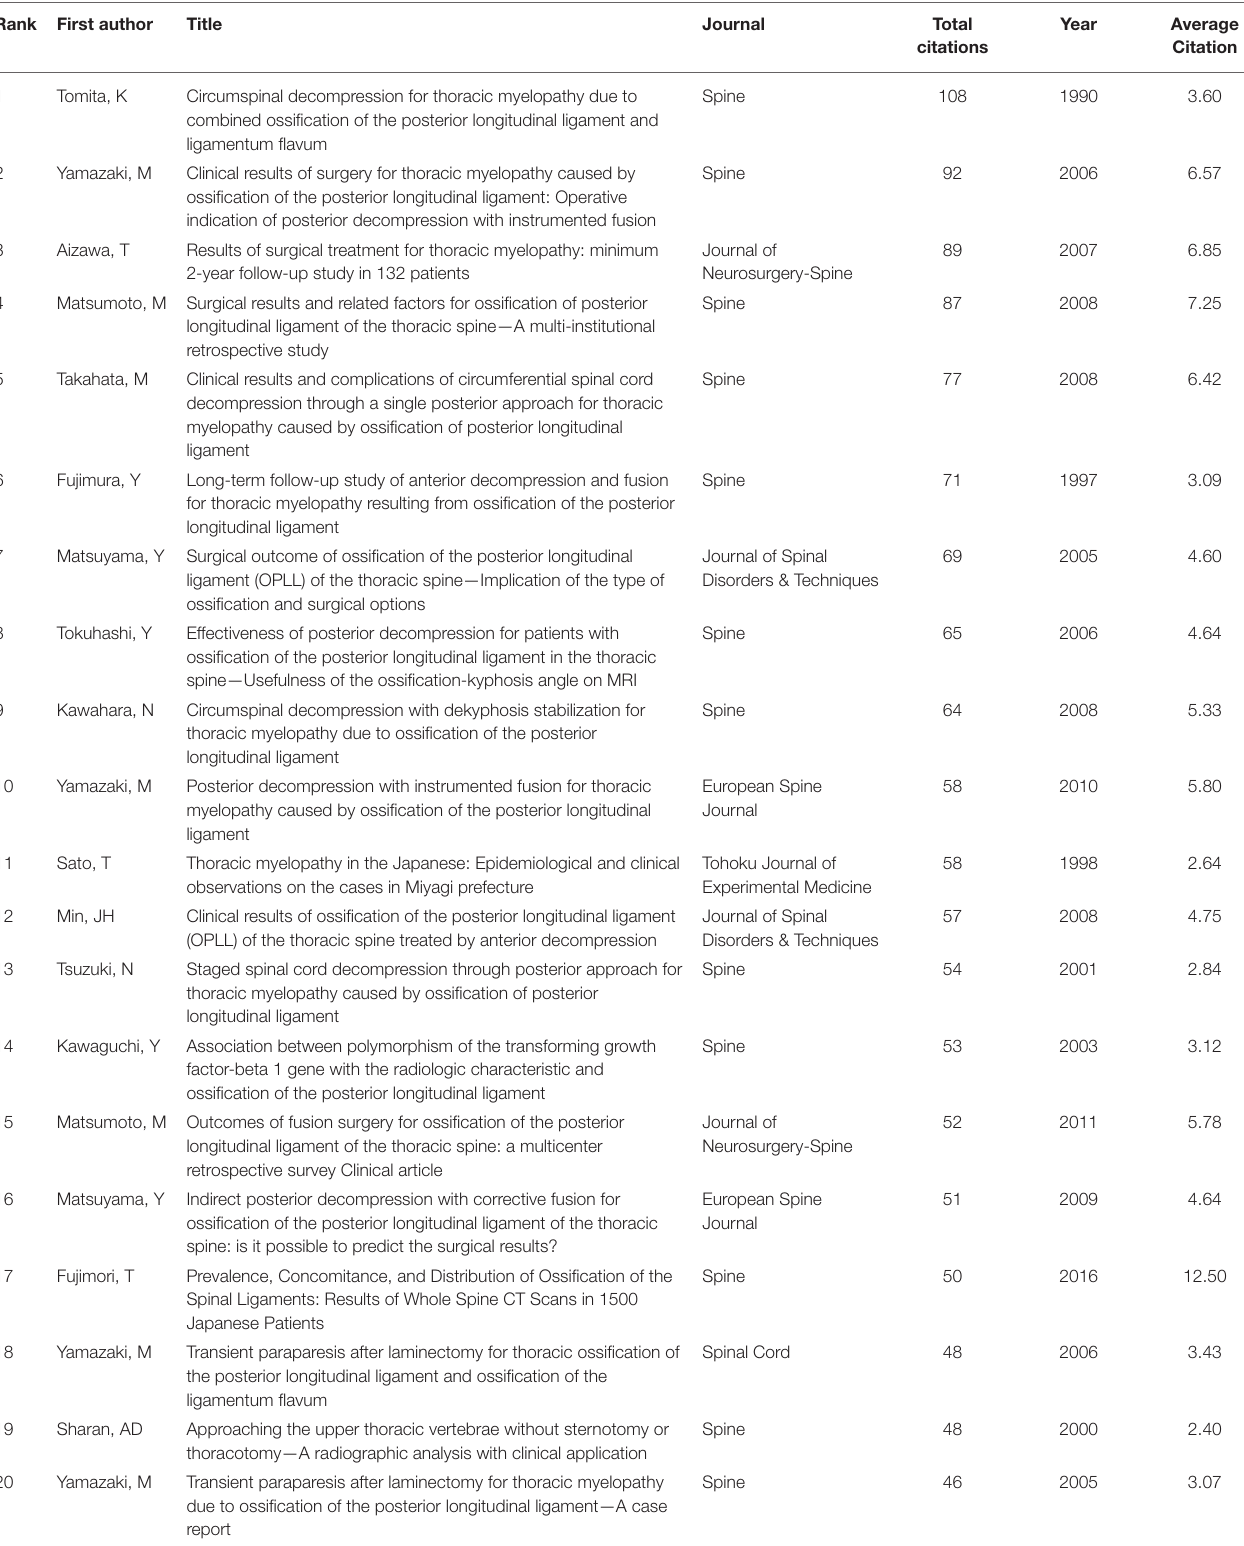
TABLE 1 | 50 Top-cited articles in the field of